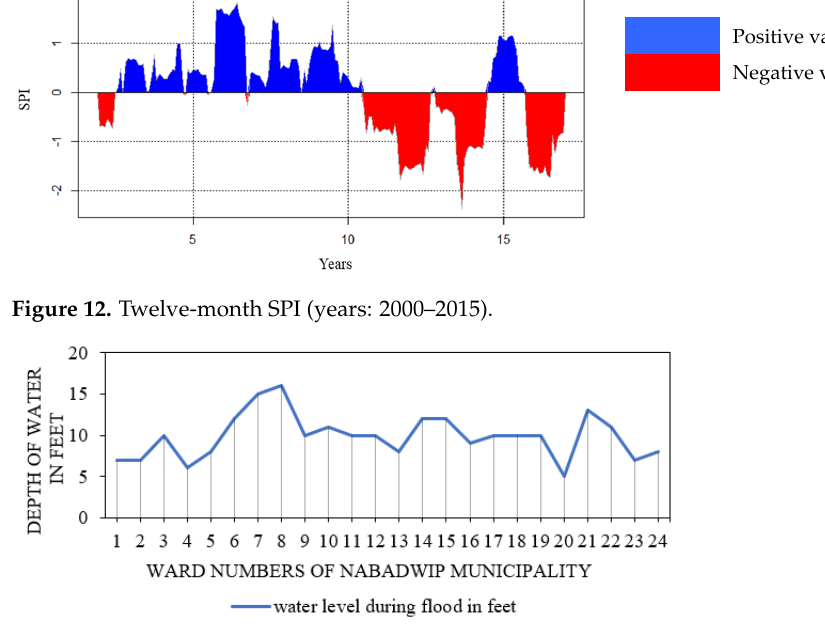
Figure 13. The water level during the recent fl ood in Nabadwip.